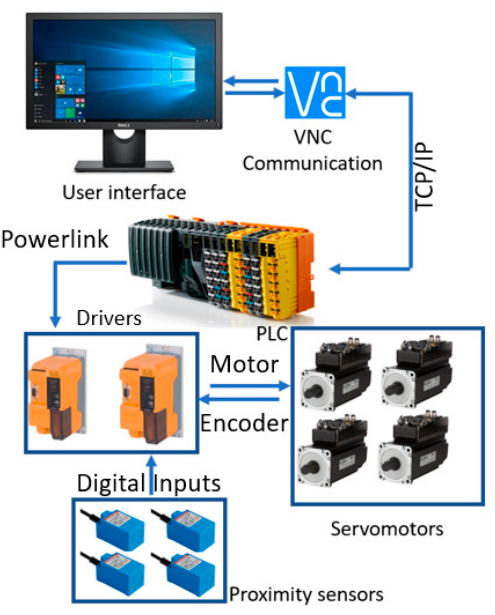
Figure 4. Control architecture of ASPIRE. PLC: Programable Logical Computer and VNC: Virtual Network Computing.